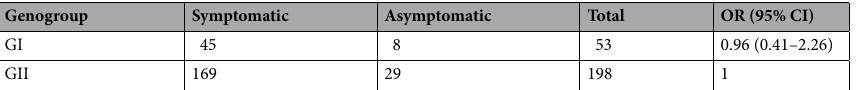
Table 4. Norovirus genogroup in symptomatic and asymptomatic infected long-term care facilities staff and residents.